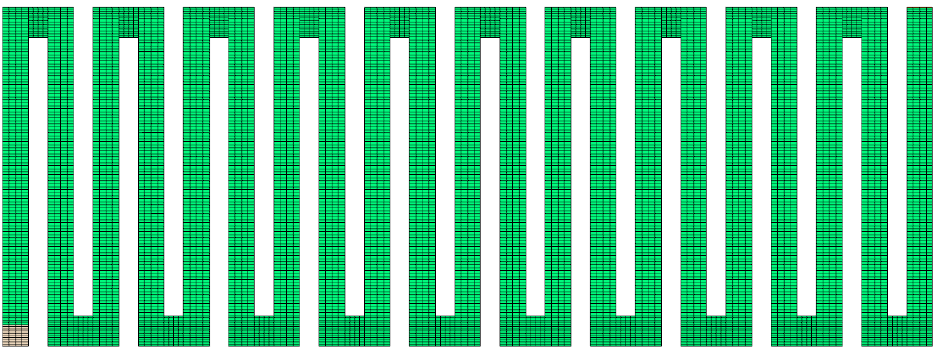
Figure 4. Mesh of the serpentine on the anode side.